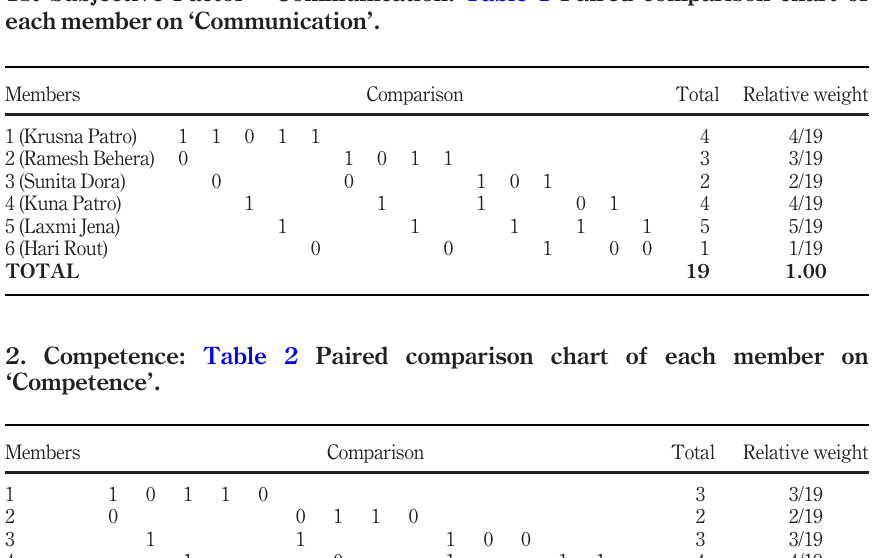
1st Subjective Factor – Communication: Table 1 Paired comparison chart of each member on ‘ Communication ’ .